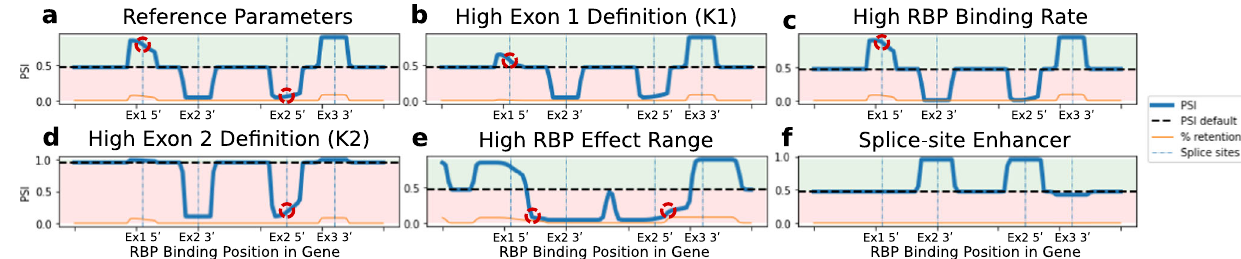
Fig. 5 Kinetic competition of exon de fi nition and RBP-mediated inhibition around splice sites. a Reference simulation for the position- dependent RBP effect. Figure 4b has been recreated with an increased Hill coef fi cient of the RBP ’ s range-dependency function (Fig. 4b, right) from 8 to 32 (see Methods, Eq. 15 ) . This results in the RBP exhibiting a quasi-binary inhibition pro fi le as a function of the binding site distance. Due to kinetic competition of exon de fi nition and RBP-mediated inhibition, the RBP effect on PSI is asymmetric up- and downstream of the 5 ′ splice sites of exons 1 and 2 (see red circles and main text). b and d Multiplication of the exon de fi nition rate parameters k1 and k2 by 5 relative to the reference simulation lowers the local magnitude of the RBP effect, while increasing RBP effect asymmetry around the relevant 5 ′ splice sites (see red circles), since exon de fi nition more ef fi ciently competes with RBP-mediated inhibition. c Multiplication of the RBP binding rate (rbp_r) by 4 slightly increases the RBP effect on PSI, with slightly more pronounced saturation when binding occurs upstream of 5 ′ the splice site of exon 1 (red circle). e Increasing the RBP effect range from 25 nucleotides (nt) to 65 nt shows that the asymmetric regulation of PSI by the RBP around 5 ′ splice sites persists if the RBP has overlaying effects on multiple splice sites (red circles). f The RBP ’ s function (Eq. 14) was altered by adding, rather than subtracting, the inhFunc term, therefore switching it to an activating function. When the RBP functions as an enhancer (activator) of splice site usage, the kinetic competition effect (RBP effect asymmetry on PSI) is not observed around the splice site that the RBP effects. This can be explained by the fact that an activator behaves non-competitively with the de fi nition of the splice sites it impacts, instead enhancing the exon de fi nition rates